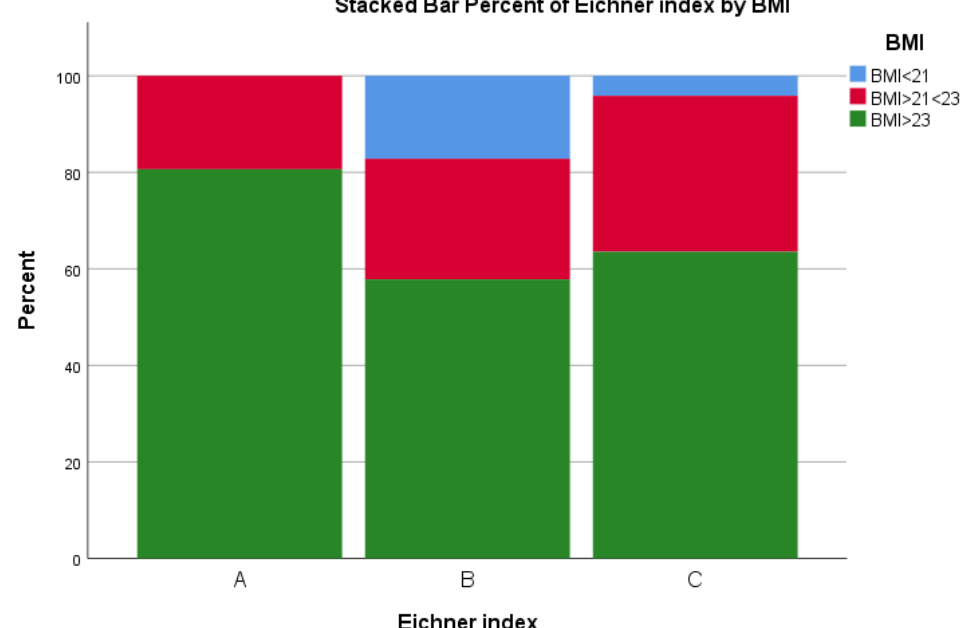
Figure 5. BMI of participants without dentures, grouped according to the Eichner index, which measures number of occluding tooth contacts. ( A ) = four occluding zones, ( B ) = one to three occluding zones or presence of occlusal contacts frontally, and ( C ) = no occluding teeth. p = 0.015.